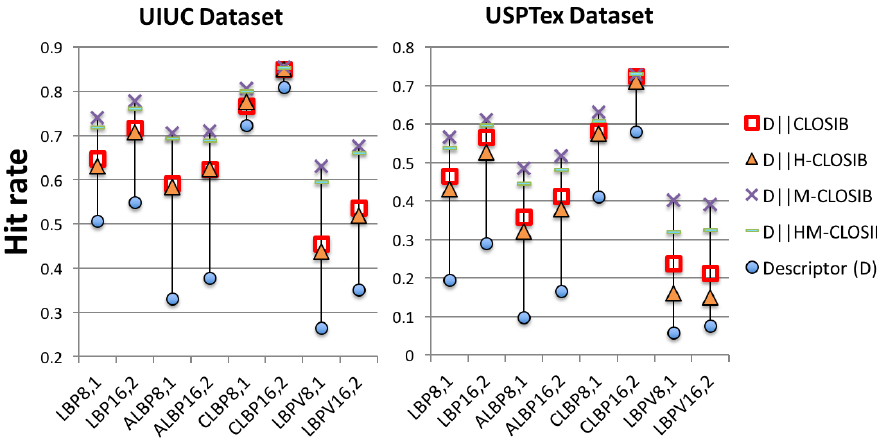
Figure 11. Results using the concatenation of LBP-based descriptors with CLOSIB variants (CLOSIB, H-CLOSIB, M-CLOSIB and HM-CLOSIB) on UIUC ( left ) and USPTex ( right )